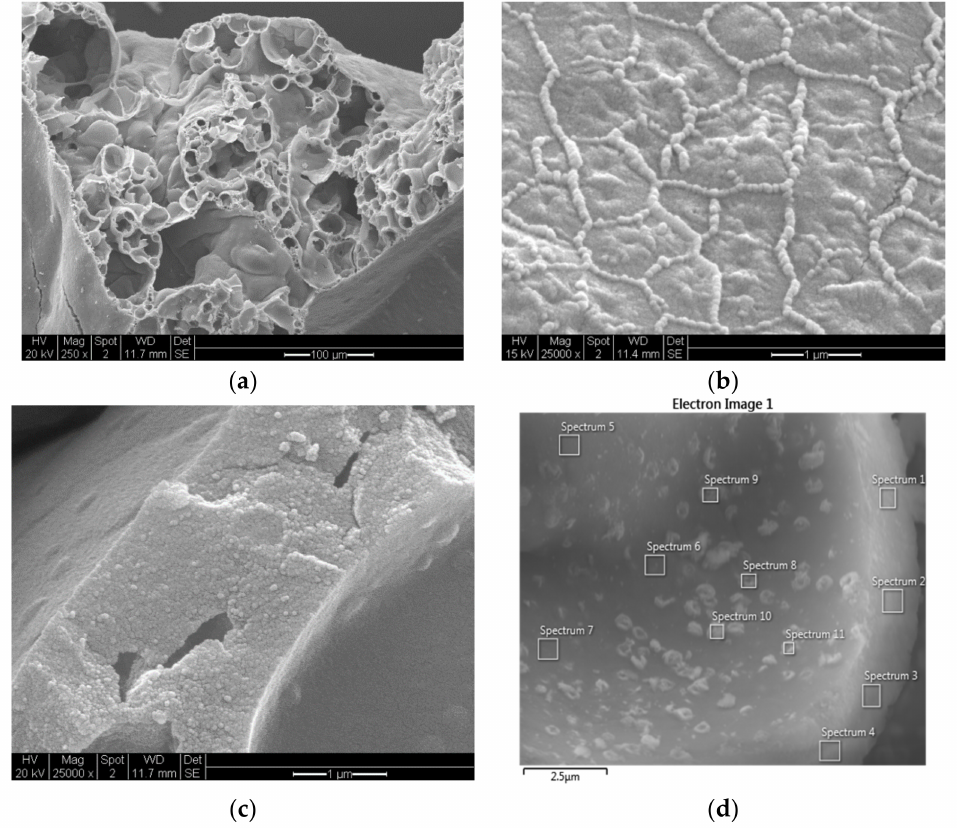
Figure 17. SEM and EDS images of Co / Si = 1 / 4 catalysts. ( a ) Fracture surface of a catalyst particle showing its porous structure (scale bar = 100 µ m); ( b ) Surface structure of the catalyst with decorations (scale bar = 1 µ m); ( c ) Pore wall structure (scale bar = 1 µ m); ( d ) EDS-image of a pore at the location of EDS-spot analysis on the wall and pore surface (scale bar = 2.5 µ m) with average concentrations: [Co] = 0.067; [Si] = 0.233; [O] = 0.700 with [Co] / [Si] = 0.288; [O] / ([Co] + [Si]) =